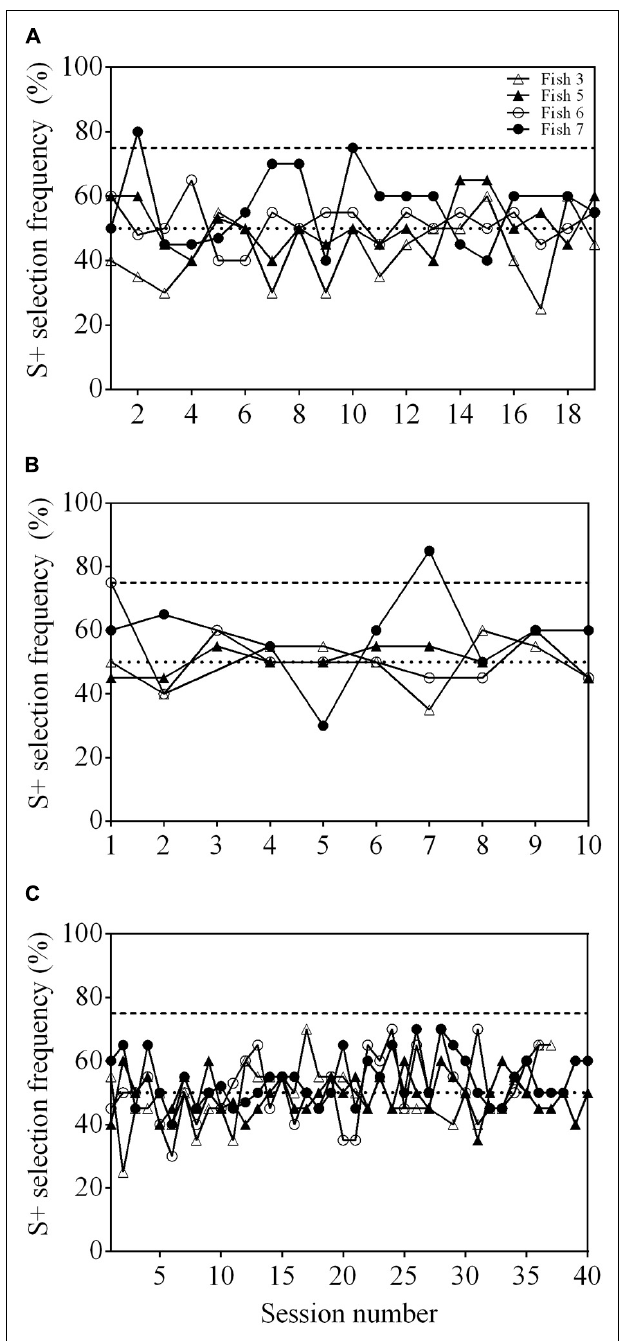
FIGURE 3 | Results of three training procedures for matched-to- sample/oddity-from-sample (MTS/OFS) tasks. (A) Learning curve of four archerfish when presented with a delayed MTS/OFS task. A pool of 10 shapes was used as stimuli. (B) Learning curve of four archerfish given a similar delayed MTS/OFS task with the modification that the pool of stimuli used was reduced to three. (C) Learning curve of four archerfish given a simultaneous MTS/OFS task using a pool of three shapes as stimuli.The dashed line at 75% in all figures indicates a statistically significant selection frequency of S + and the dashed line at 50% indicates chance. Filled symbols represent fish trained to an OFS task and empty symbols represent fish trained to a MTS task. See Table 1 for example